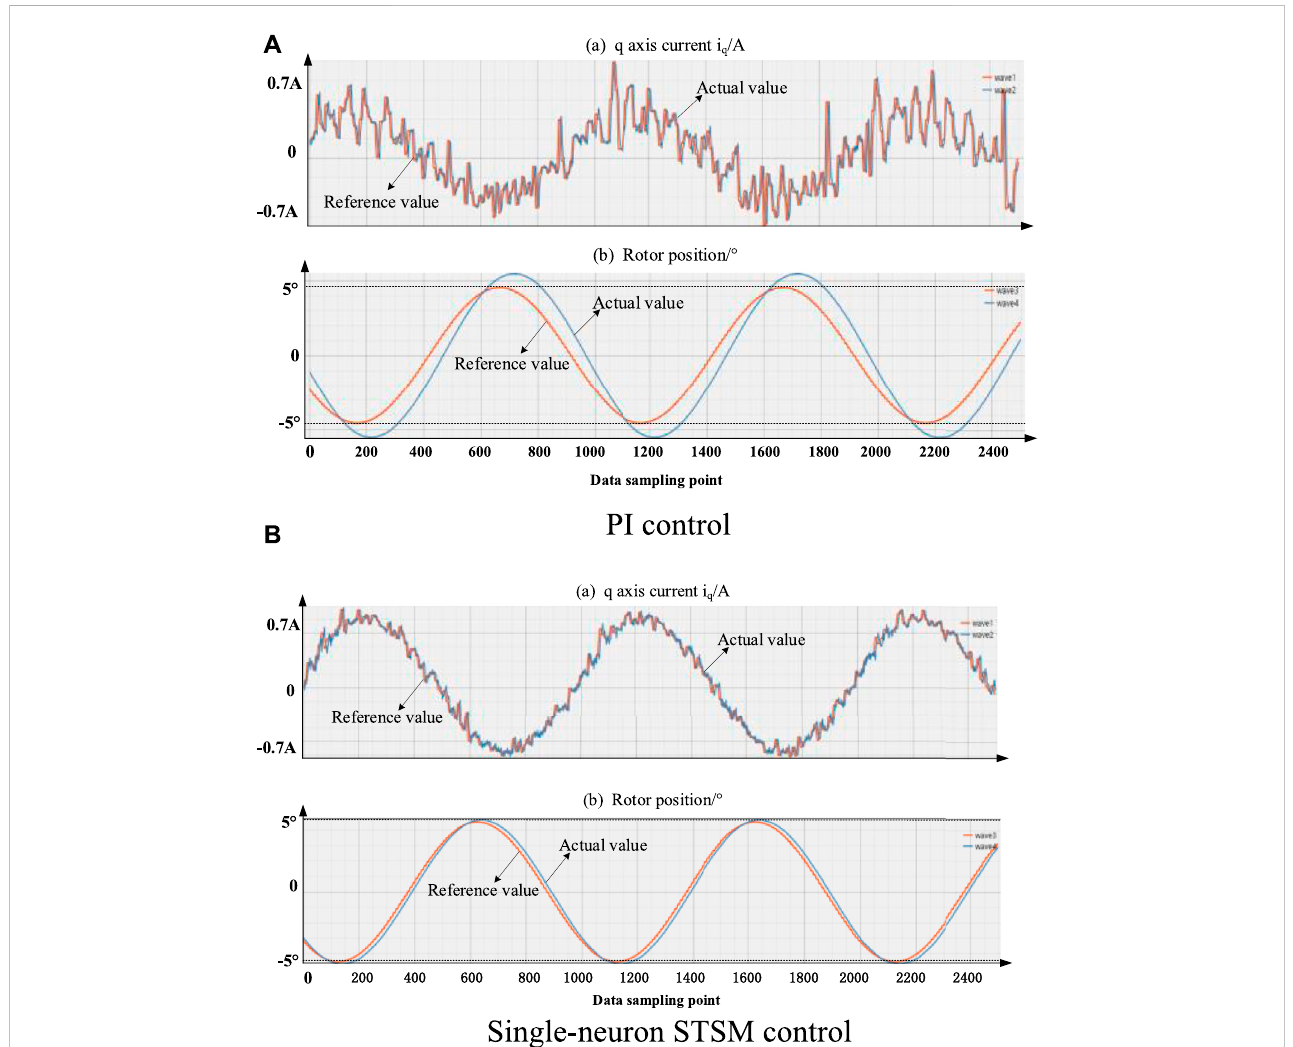
FIGURE 8 Experimental results when the reference value sine wave signal. (A) PI control; (B) Single-neuron STSM